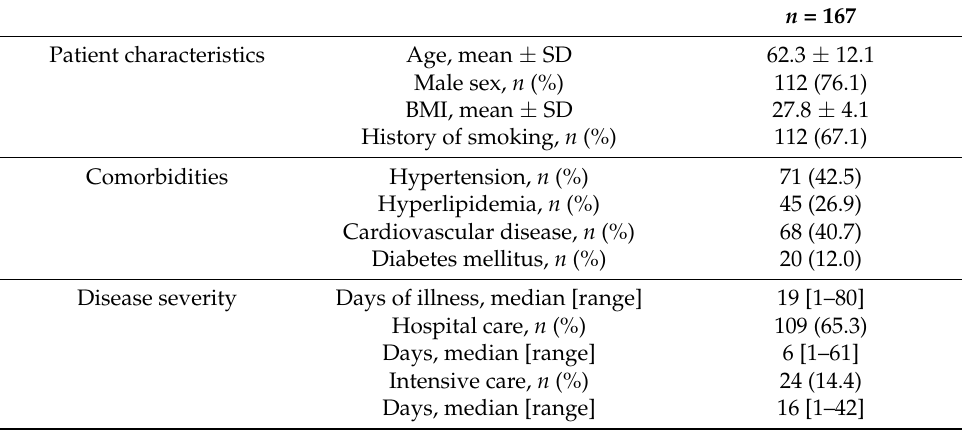
SD = standard deviation, BMI = body mass index.